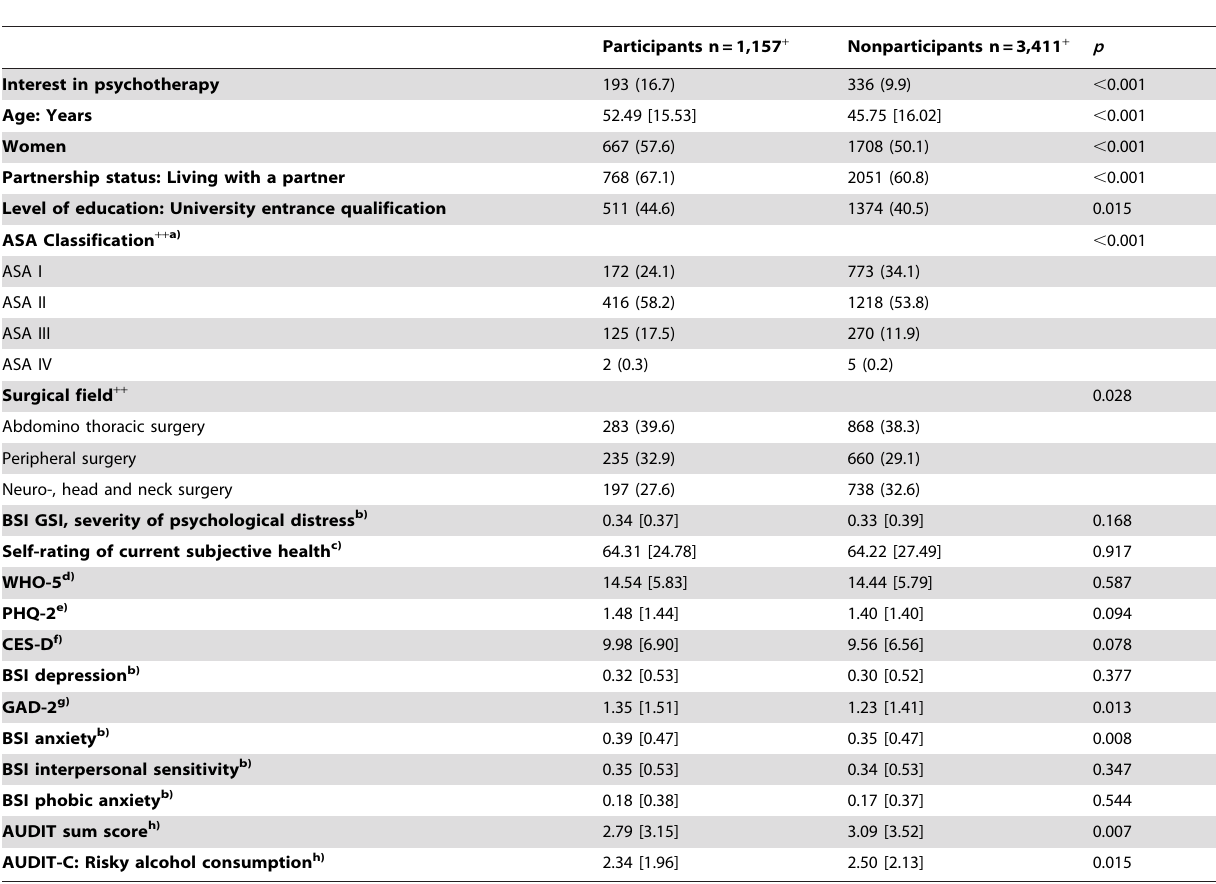
Table 2. Comparisons of participants (n= 1,157) and nonparticipants (n= 3,411) of the 6-month follow-up; n (%); mean